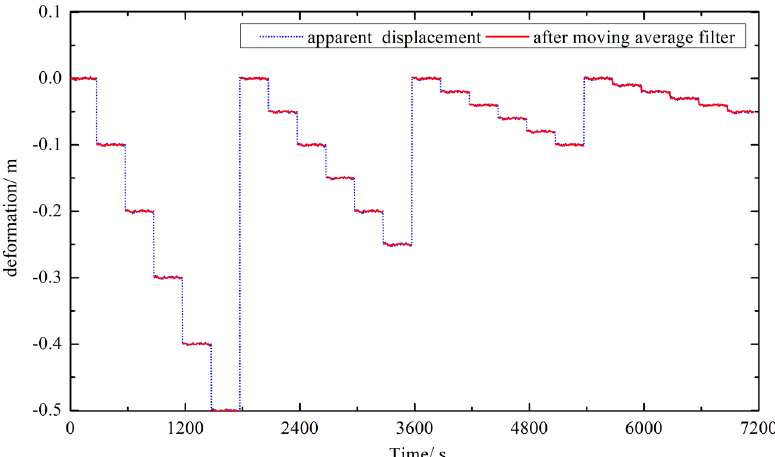
Figure 15. Automated horizontal shift detection based on deformation. The antenna was shifted repeatedly at distances ranging from 10 cm to 1 cm. The blue dot line is the apparent displacement derived from short baseline solution. The red line is the deformation after applying the moving average filter method. Table 5. Evaluation of horizontal shift from 10 cm to 1